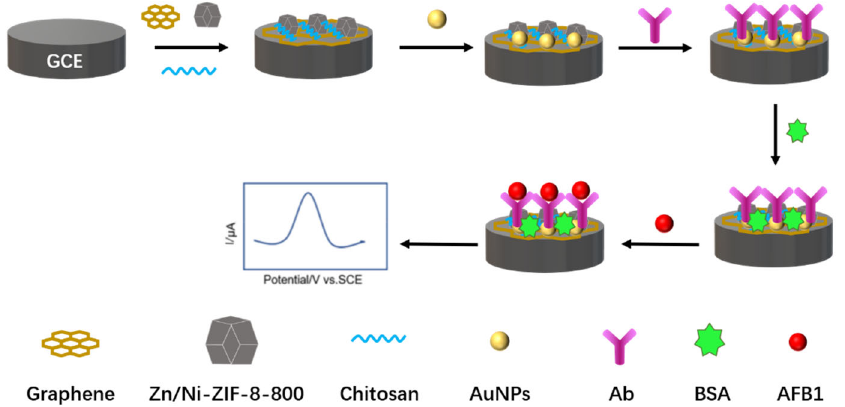
Figure 11. Schematic of an electrochemical immunosensor for the detection of aflatoxin B1 (Adapted with permission from Ref. [35]. 2022, Wang et al.).